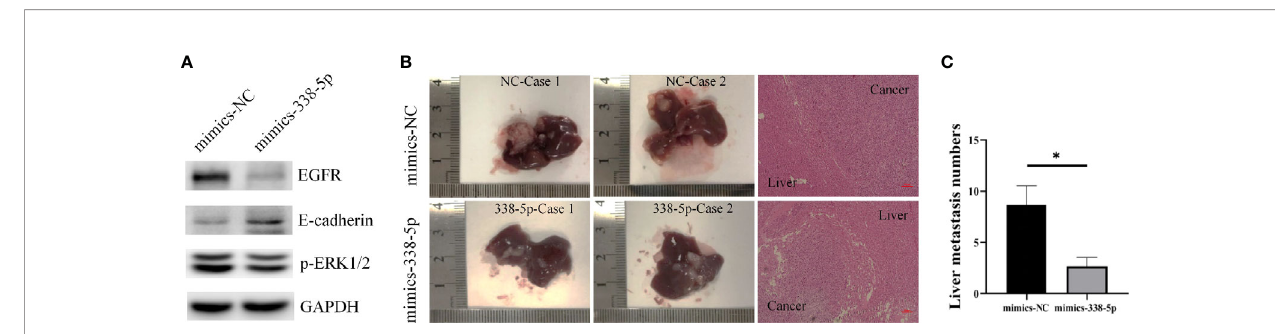
FIGURE 6 | MiR-338-5p inhibited liver metastases in vivo . (A) the protein levels of EGFR, E-cadherin, and p-ERK in PANC02 cells transfected with mimics NC or miR-338-5p mimics detected by western blot. (B) Liver metastases and corresponding HE staining (100×) in mimics-NC and mimics-338-5p groups. (C) The statistical analysis of liver metastasis number between mimics-NC and mimics-338-5p groups. Bars indicate ± SEM. *P < 0.05 compared with the